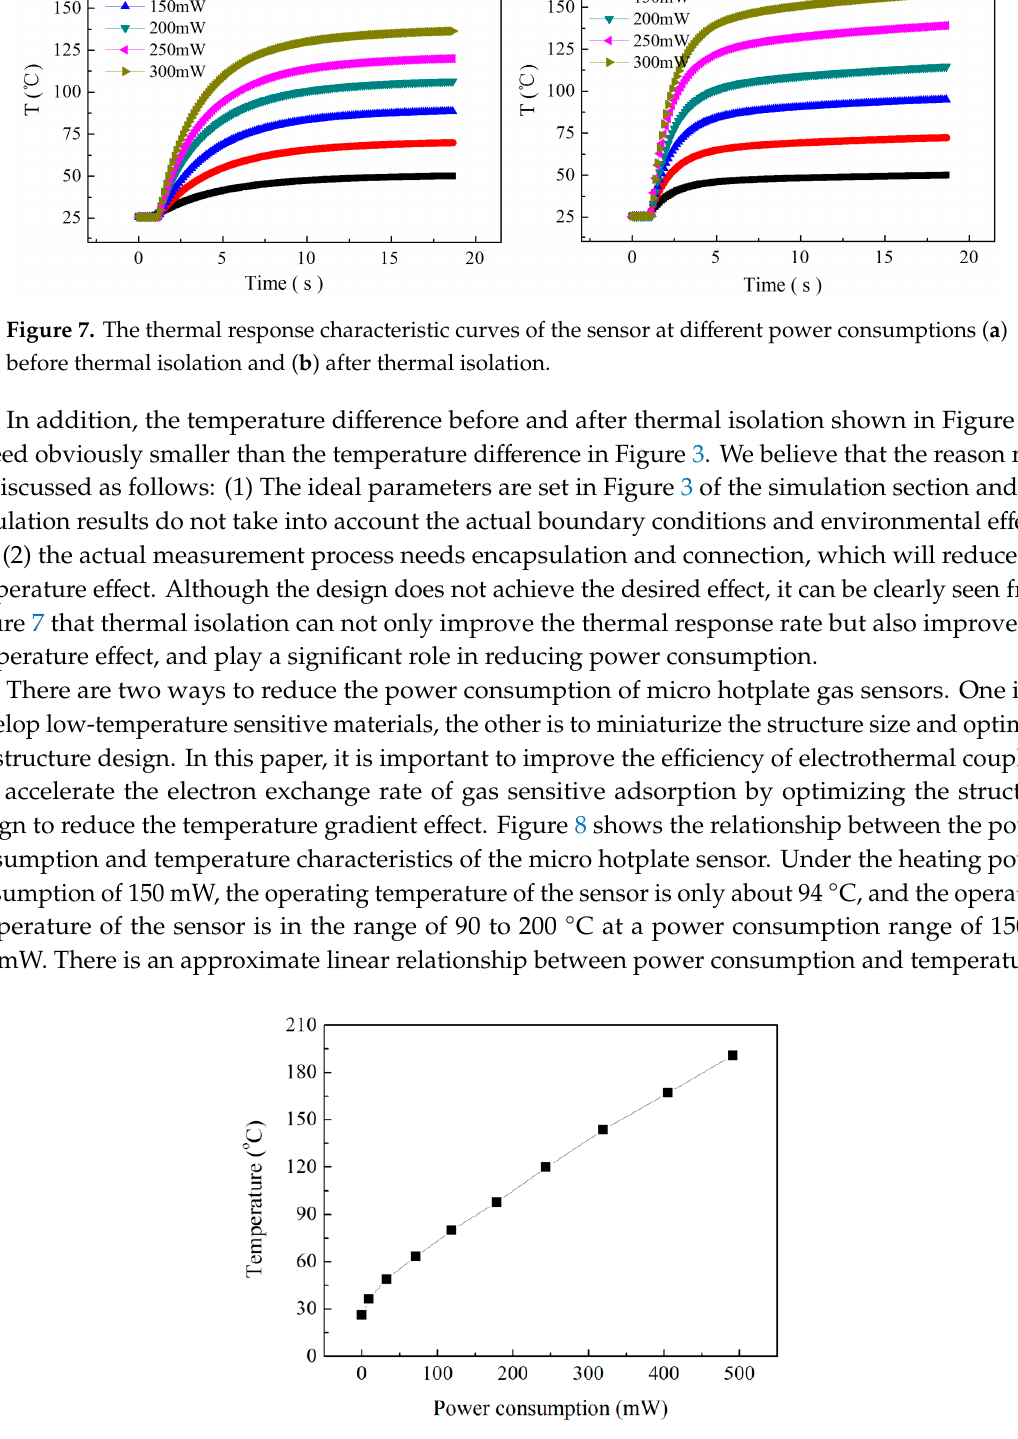
Figure 8. The relationship between the power consumption and temperature characteristics of the micro hotplate sensor.